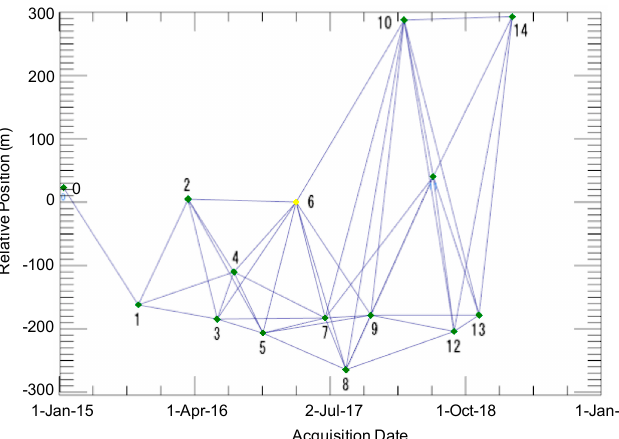
Figure 4. Temporal and spatial baseline distributions of the SAR interferogram, acquired from 15 ALOS ‐ 2 PALSAR ‐ 2 data points (the normal baseline restriction used was up to 50% of the critical baseline, and the time interval between the interferometric pair was up to 365 days). Each number shows the acquisition date (Table 2).